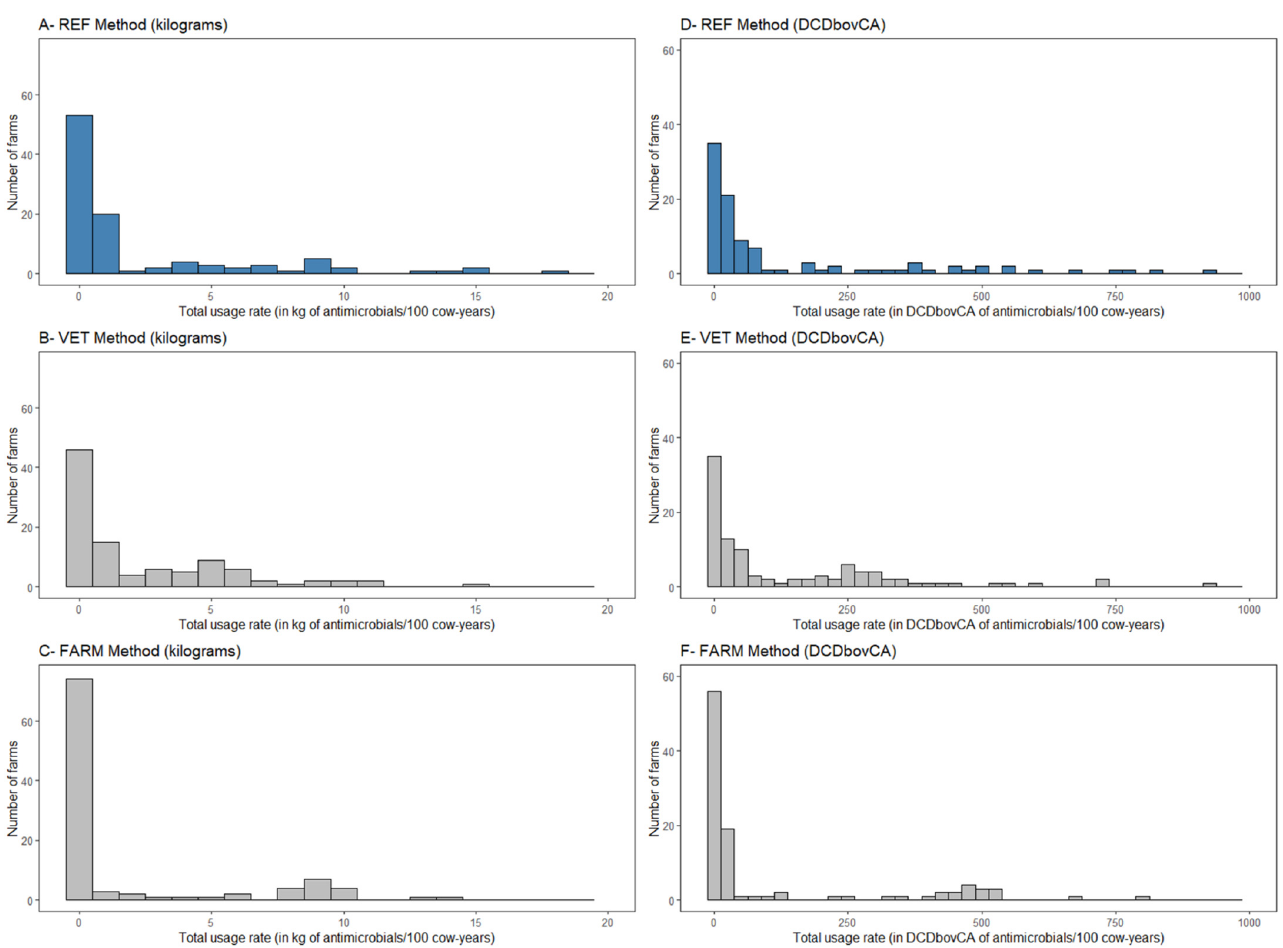
Figure 1. Distribution of total usage rates of antimicrobials in feed (in kg/100 cow-years, ( A – C ), and in DCDbovCA/100 cow-years, ( D , E )) calculated for 101 dairy farms from Qu é bec, Canada, using three quantification methods: invoices from feed mills (REF method, histograms ( A , D )), veterinary prescriptions (VET method, histograms ( B , E )), and in-person interviews of dairy producers (FARM method, histograms ( C , F